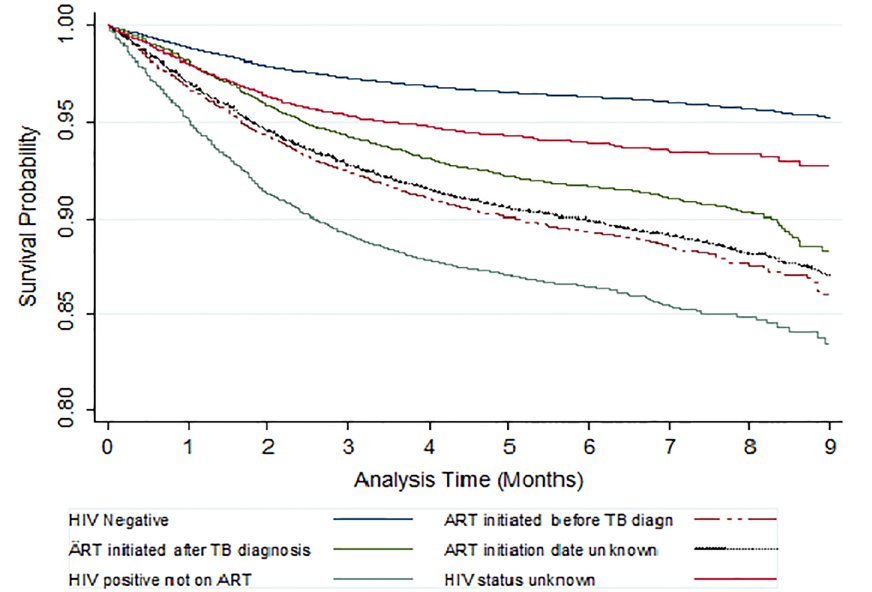
Fig 1. Survival of patients on tuberculosis treatment by their HIV and ART status. https://doi.org/10.1371/journal.pone.0188235.g001 with death (Table 2). Patients who were HIV positive but not on ART were almost four times likely to die than HIV negative patients (HR = 3.9, 95% CI: 3.6–4.3). The risk of dying increased with increasing age; those aged (cid:21) 75 years were seven times more likely to die than those aged 15 to 24 years (HR = 7.0, 95% CI-6.3–7.9). In multivariable analysis, HIV status, age, disease type, treatment history, HIV, and geo- graphic region were independently associated with death (Table 2). In an initial main effects Table 1. Excessmortality among TB patients diagnosed in Kenya, 2013 to 2014, by age and sex. Sex (age group, Standardized Mortality Rate (95% Observed mortality rate/ Expected mortality rate/ Excess mortality/100-person years in years) confidence interval) 100 person-years 100 person-years (95% confidence